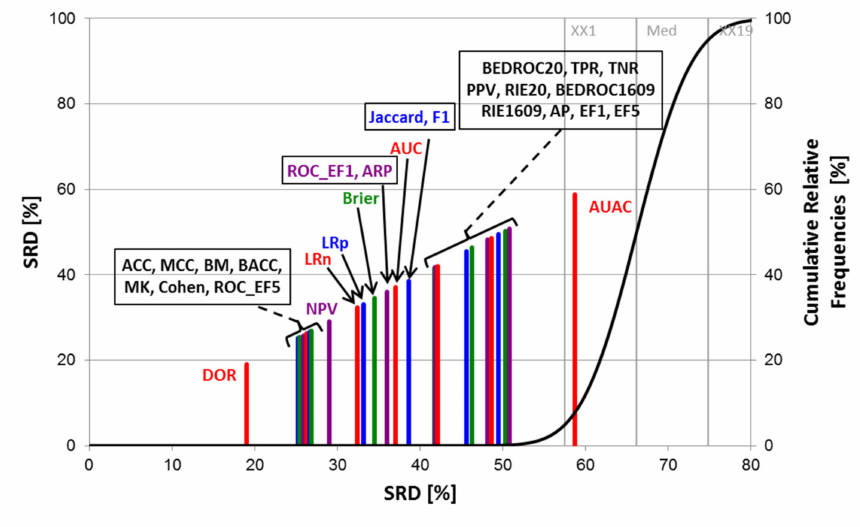
Figure 3. SRD analysis (for the balanced 2-class version). Normalized SRD values are plotted on the X and left Y axes (to make the ordering visually illustrative) - the smaller the better. The abbreviations of the performance metrics can be found in the Section 3.3. The cumulative relative frequencies (right Y axis) correspond to the randomization test (see Section 3.4). Here, the diagnostic odds ratio (DOR) is closest to the reference (smallest SRD value), while AUAC (area under the accumulation curve) overlaps with the cumulative frequency curve, and is therefore statistically indistinguishable from random